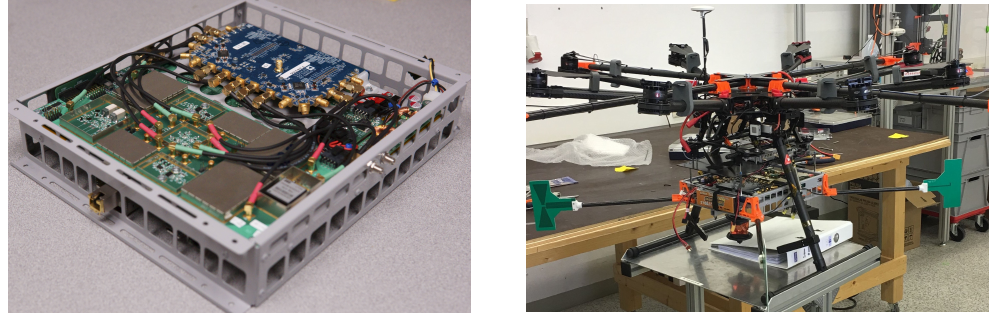
Figure 11. Electronics mounted in an aluminum enclosure ( left ) then mounted to the DJI S1000+ UAV platform for flight testing. ( right ) Initial hardware prototype of the CHP2